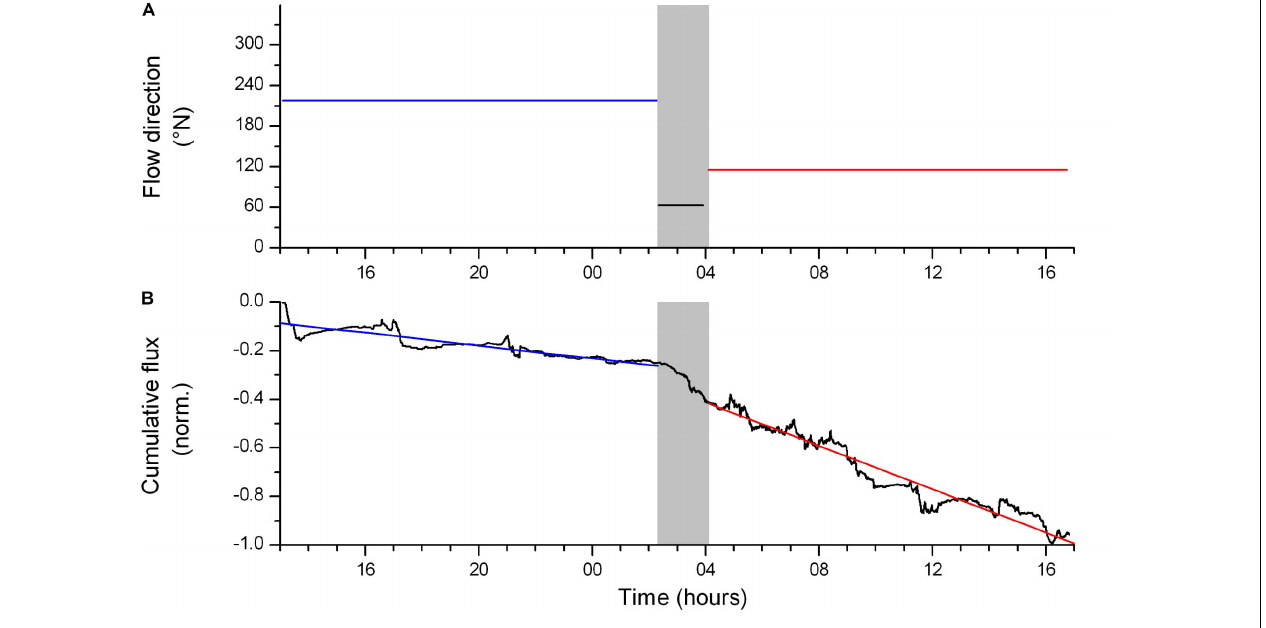
FIGURE 5 | (A) Dominant flow direction during the deployment at summit of Haas mound (i.e., SHM3), (B) normalized cumulative O 2 flux at summit of Haas mound (SHM3). Note that a linear change of the cumulative flux over time indicates stable conditions and thus well-developed fluxes. Linear sections (red and blue lines) indicate the main flux contributions from the two AEC footprints. The shaded time frame represents a transitional period in the flow direction which resulted in flow disturbances by the lander structure and overall unstable flux conditions. Deployment time is in hours after 30-Apr 00:00